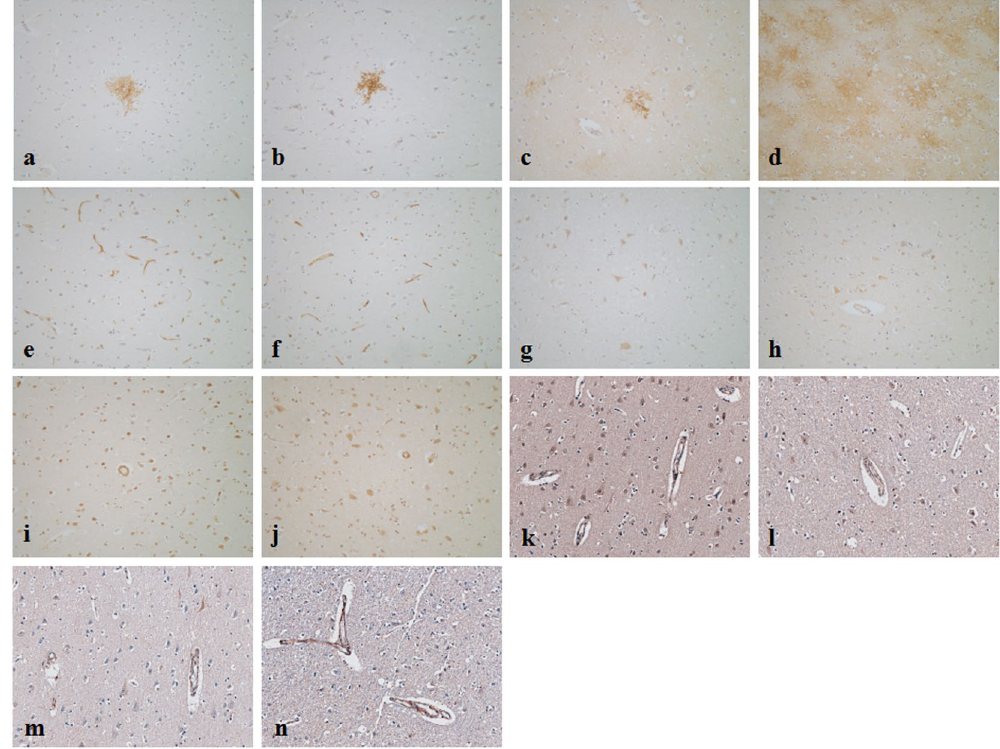
Figure 6. Immunostaining of AQP1 ( a and b ), AQP4 ( c and d ), CLDN5 ( e and f ), MMP2 ( g and h ), MMP9 ( i and j ), OCLN ( k and l ) and ZO1 ( m and n ) in the brain. Peracute death due to blunt injury ( a , c , e , g , i , k and m ), a 52-year-old male, 27 h postmortem. Death due to heat stroke ( b , d , f , h , j , l and n ), a 64-year-old male, 30 h